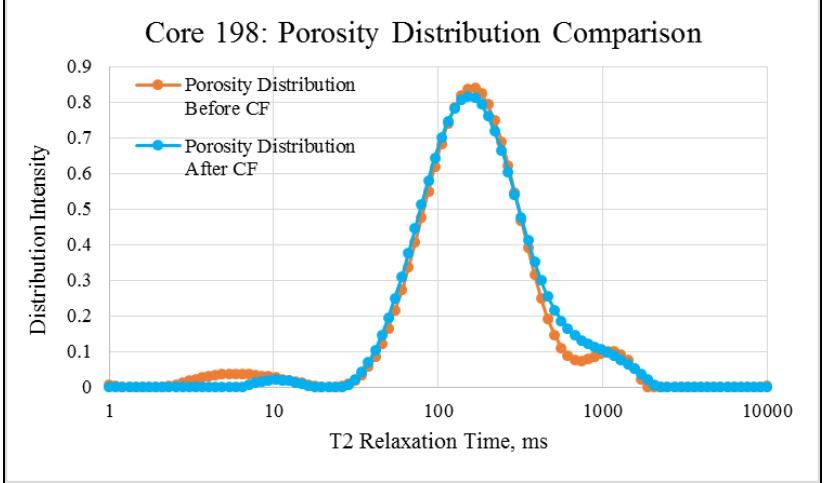
Figure 10. NMR porosity distribution comparison of C#198: before and after the coreflood.